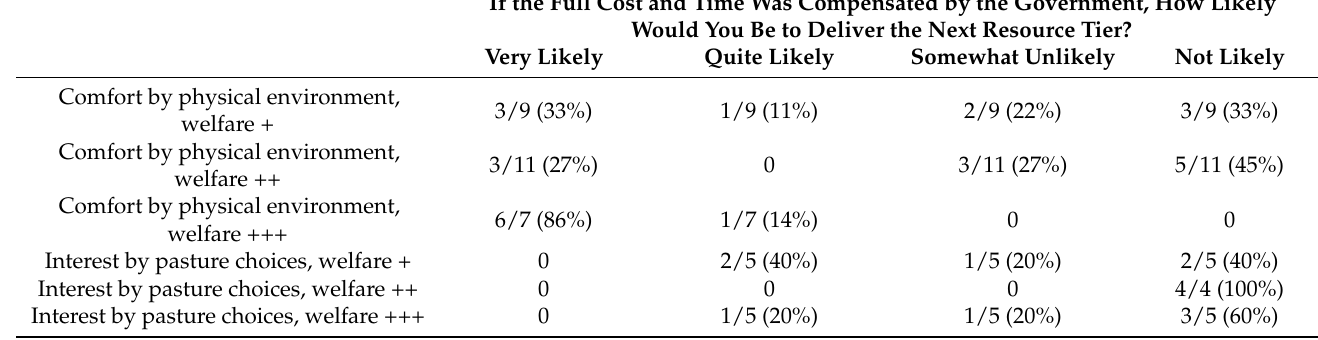
Table 6. Likelihood reported by farmers of achieving positive welfare opportunities given govern- ment